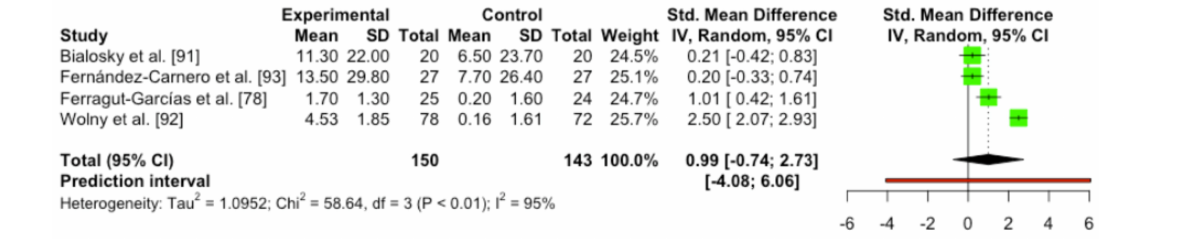
Figure 7. Meta-analysis of neural gliding trials. Positive values = In favor of intervention/Negative values = In favor of sham intervention. Standard Deviation (SD); Standard (std); Inverse Variance (IV); Confidence Interval